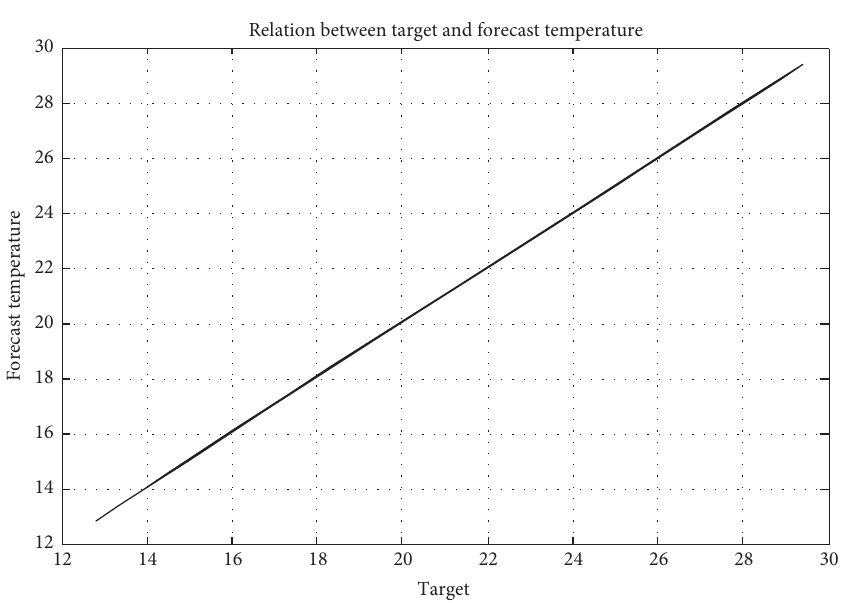
Figure 17: Relationship between target and forecast